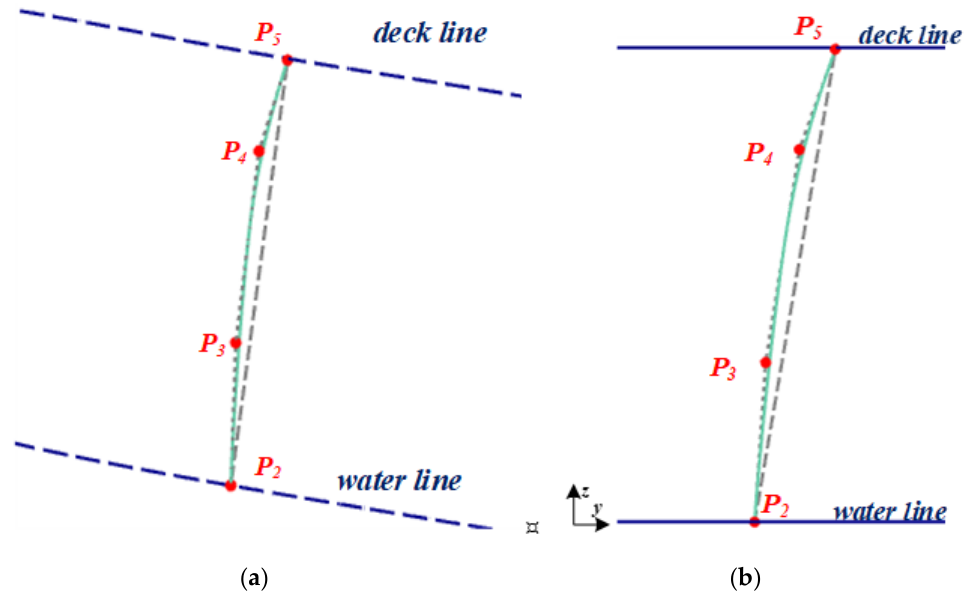
Figure 12. Schematic of the upper curve. ( a ): spatial position relationship; ( b ): shape of the curve on the X-plane.